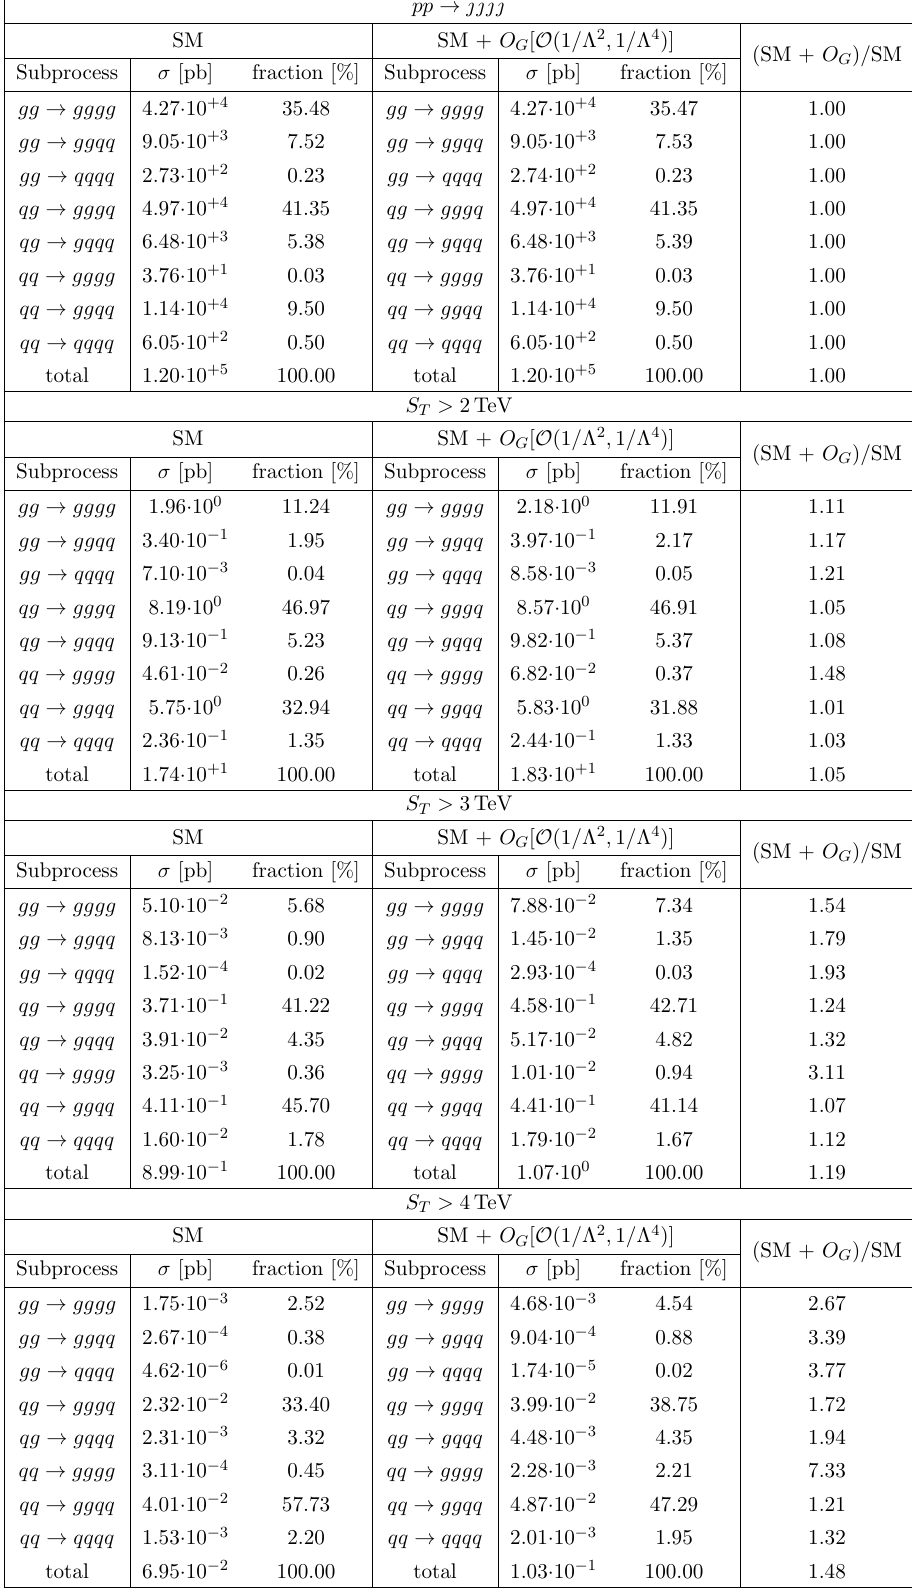
Table 5 . Contributions from the di(cid:11)erent partonic subprocesses to the production of four partonic jets at LHC13 in the SM ( O (1 = (cid:3) 0 )) and when allowing at most one O G insertion in the amplitudes ( O (1 = (cid:3) 2 ) and O (1 = (cid:3) 4 )). { 29